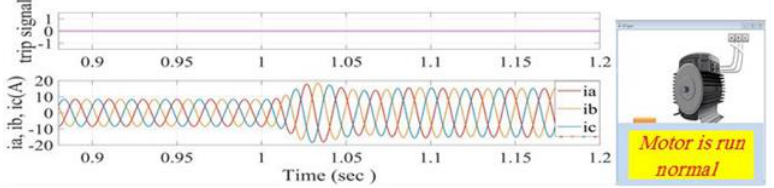
Figure 18. Stator current and trip signals for no-load to full load condition within the diagnosis